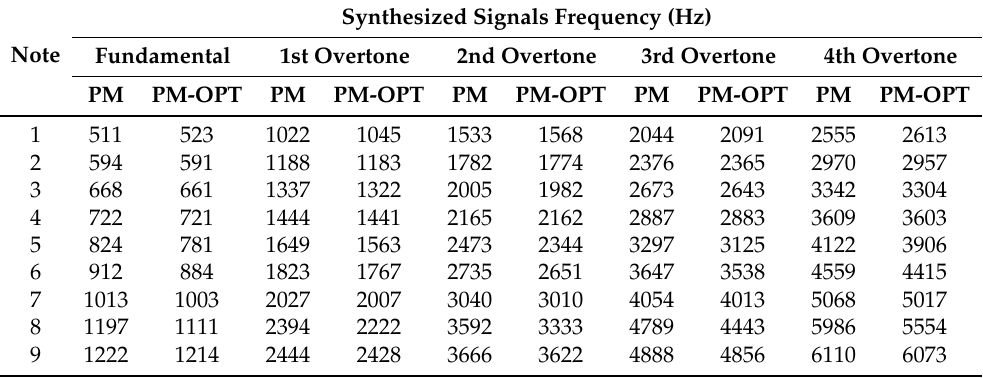
Table 2. The first five partials of the synthesized signals without adopting the optimal correction factors (PM) and after adopting the optimal correction factors (PM-OPT) per 9 notes, in